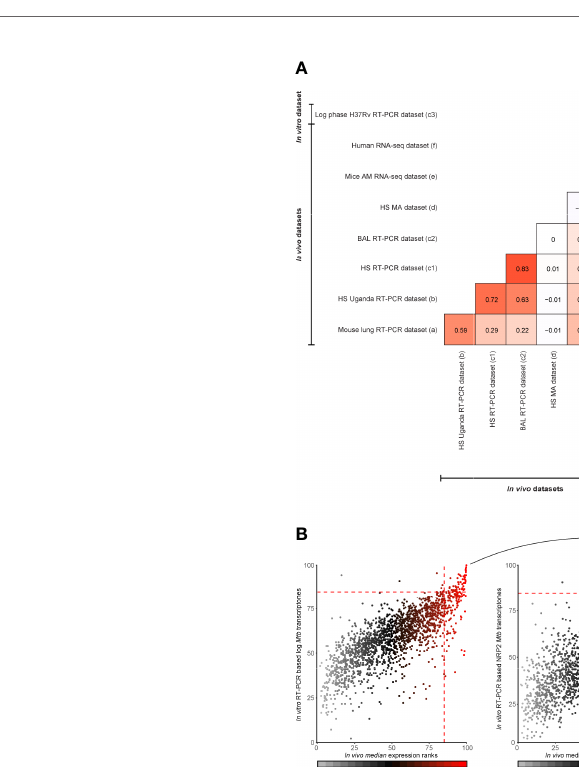
FIGURE 2 | In vivo and in vitro Mtb transcriptome dataset comparison. (A) Correlation between in vivo and in vitro Mtb transcriptome datasets (n=nine) measured using Spearmans rank correlation coef fi cients “ r ” (from 1 to -1). This comparison was based only on the ranked expression of Mtb genes (n=1813) investigated in all nine Mtb transcriptomes. The datasets included are the following: C3HeB/FeJ mouse lung dataset (8) (a); human sputum (HS) dataset from Ugandan TB patients (10) (b); HS (c1) and BAL (c2) from a cohort of South African TB patients (12); a microarray (MA) based dataset (15) (d) from sputa of Indian TB patients (15); RNA- Seq dataset from alveolar macrophages (AM) of Mtb infected C57BL/6J mice (GEO: GSE132354)] (e); and RT-PCR based datasets from log phase aerobic grown Mtb H37Rv (c3) and non-replicating persistence state (NRP-2) cultured Mtb H37Rv (c4). (B) Scatter plots (left and middle panel) displaying the relationship between the median expression ranks of the four published in vivo RT-PCR based Mtb transcriptomes (datasets a, b, c1 and c2) (x-axes) and the median expression ranks of the two published in vitro RT-PCR based Mtb transcriptomes (c3 and c4, left and right plot, respectively) (y-axes). Dots are color coded according to the median expression ranks of the in vivo datasets. At the value of 85%, dotted lines intersect the axes indicating the top 15% expressed Mtb genes. Venn diagram (right panel) showing the numbers of top ranked in vivo Mtb genes (n=90), described in Figure 1 , that overlap with the top ranked in vitro Mtb genes from log phase aerobic grown Mtb H37Rv and non-replicating persistence state (NRP-2) cultured Mtb